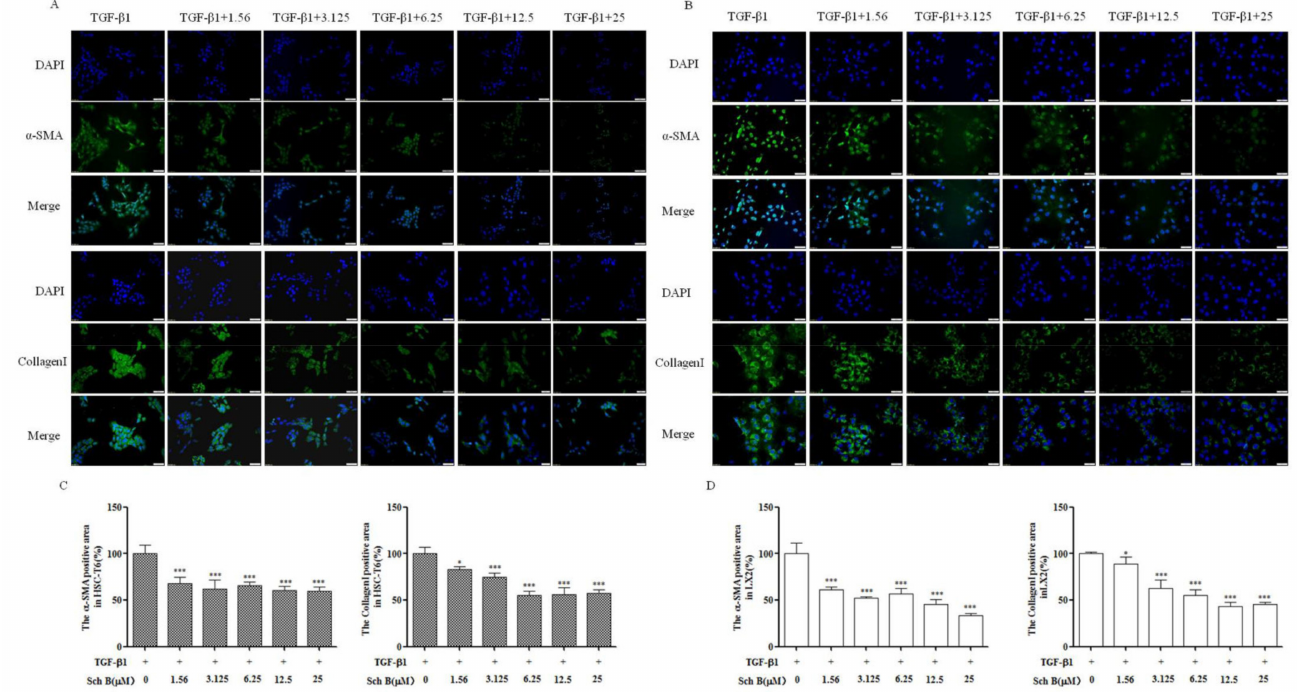
Figure 3. Sch B suppressed the proteins expression of α -SMA and Collagen I. Immunofluorescence analysis of α -SMA and Collagen I expression in HSC-T6 ( A ) and LX-2 ( B ) cells; magnification, 200 × . The positive areas were quantified in HSC-T6 ( C ) and LX-2 ( D ) cells. * p < 0.05, *** p < 0.001, significantly different when compared with the TGF- β 1-activated